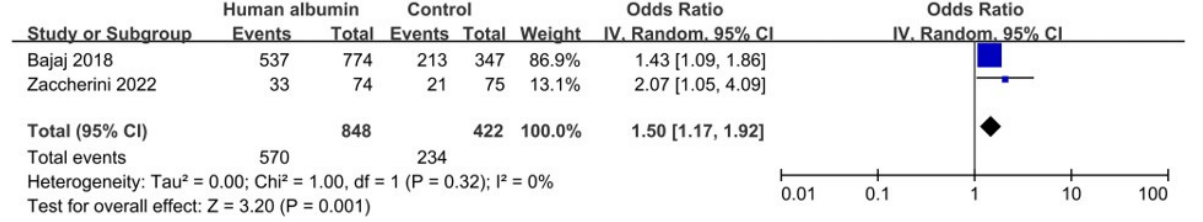
Figure 5. Forrest plots showing the effect of human albumin infusion on the resolution of hypo- natremia in liver cirrhosis with hyponatremia.